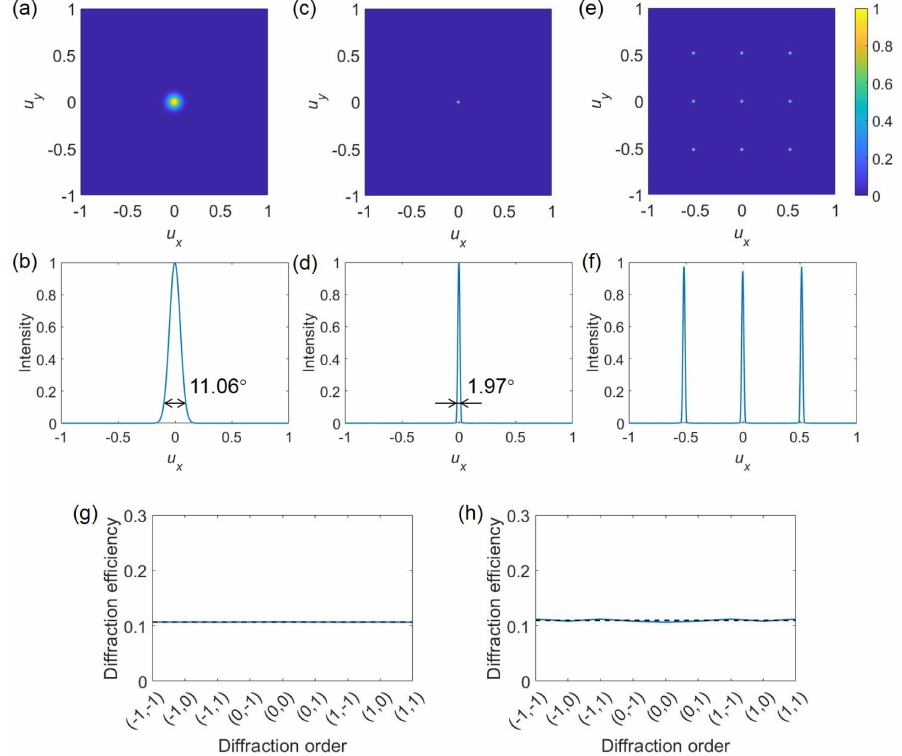
Figure 4. Far-field results of the metafiber-based collimating splitter using angular spectrum propa- gation theory. ( a , b ) Two-dimensional and one-dimensional (when u y = 0) far-field intensity of the incident Gaussian beam without collimating. ( c , d ) Two-dimensional and one-dimensional far-field intensity of the collimated Gaussian beam using a metalens with a phase profile of φ L . ( e , f ) Two- dimensional and one-dimensional (when u y = 0) far-field intensity of the collimated beam array using the designed metasurface collimating splitter with a phase profile of φ . u x and u y denote the direction cosine and are equal to sin θ x and sin θ y , respectively. ( g ) Diffraction efficiency of the Dammann grating extracted from different diffraction orders for comparison. The dashed line is 0.107 (to guide the eye). ( h ) Diffraction efficiency of the metasurface collimating splitter extracted from different diffraction orders corresponding to ( e ). The dashed line is 0.11 (to guide the